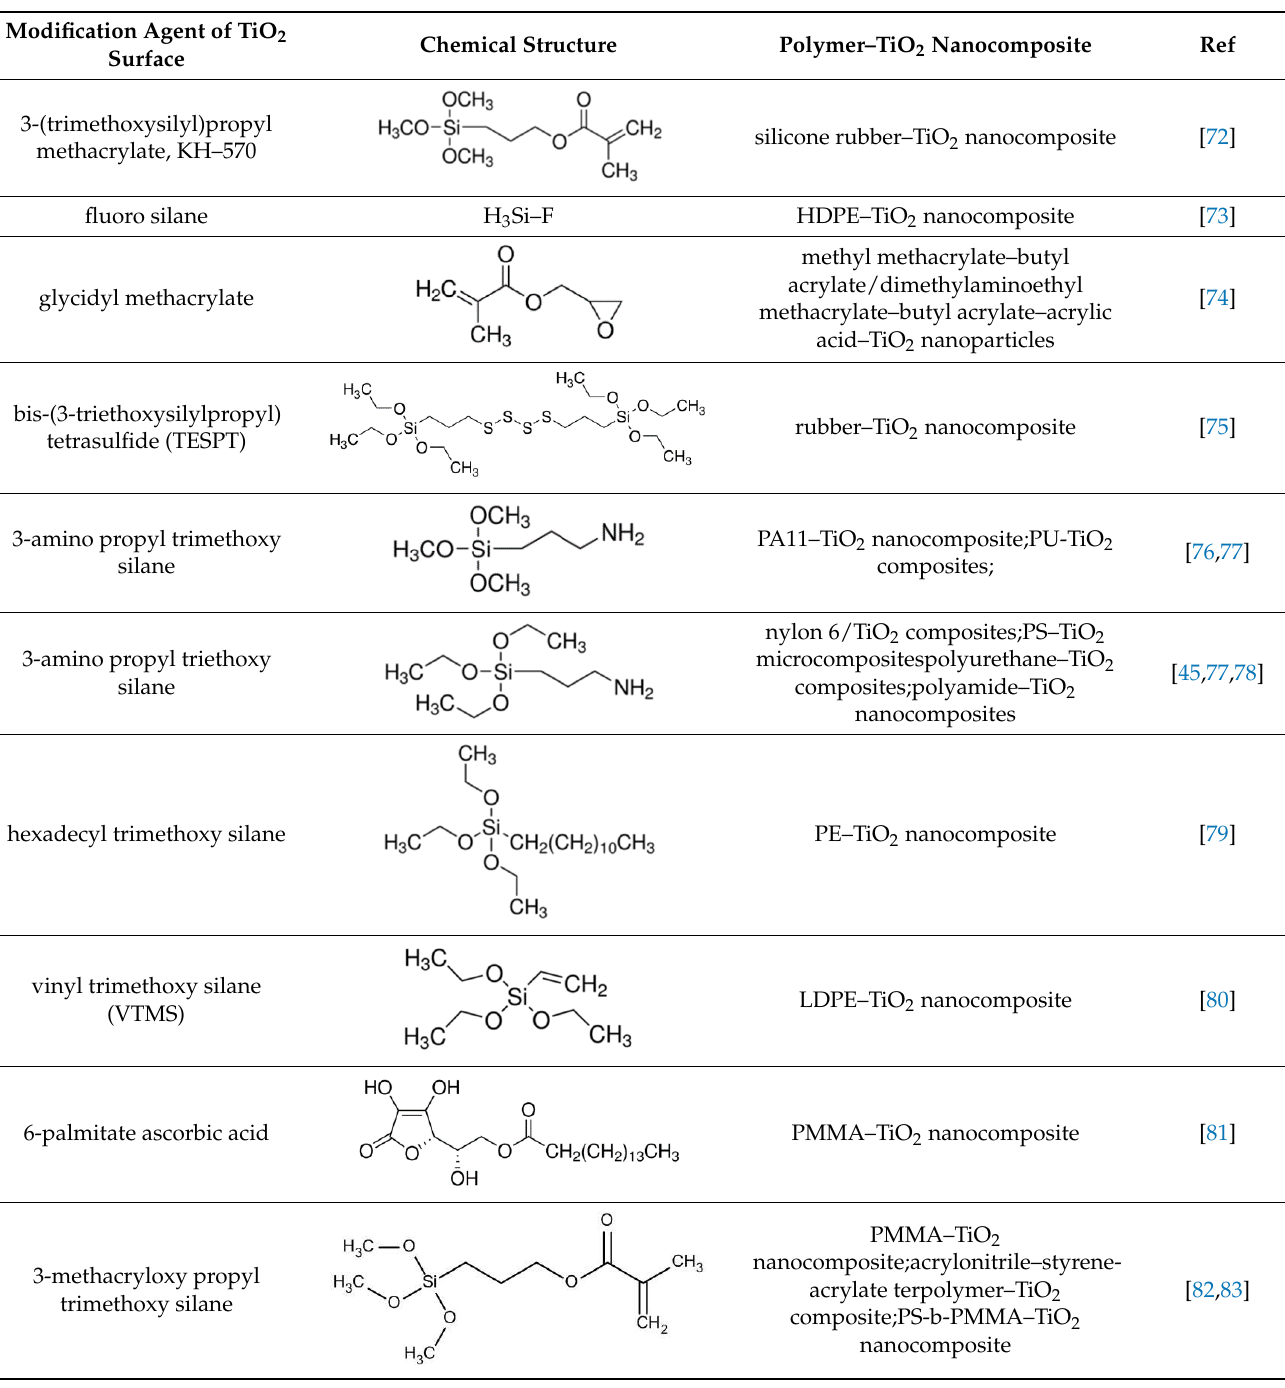
Figure 3. The interaction between the coupling agent molecule and the filler. ticles is given in Table 1. Table 1. Surface modification of TiO 2 nanoparticles.